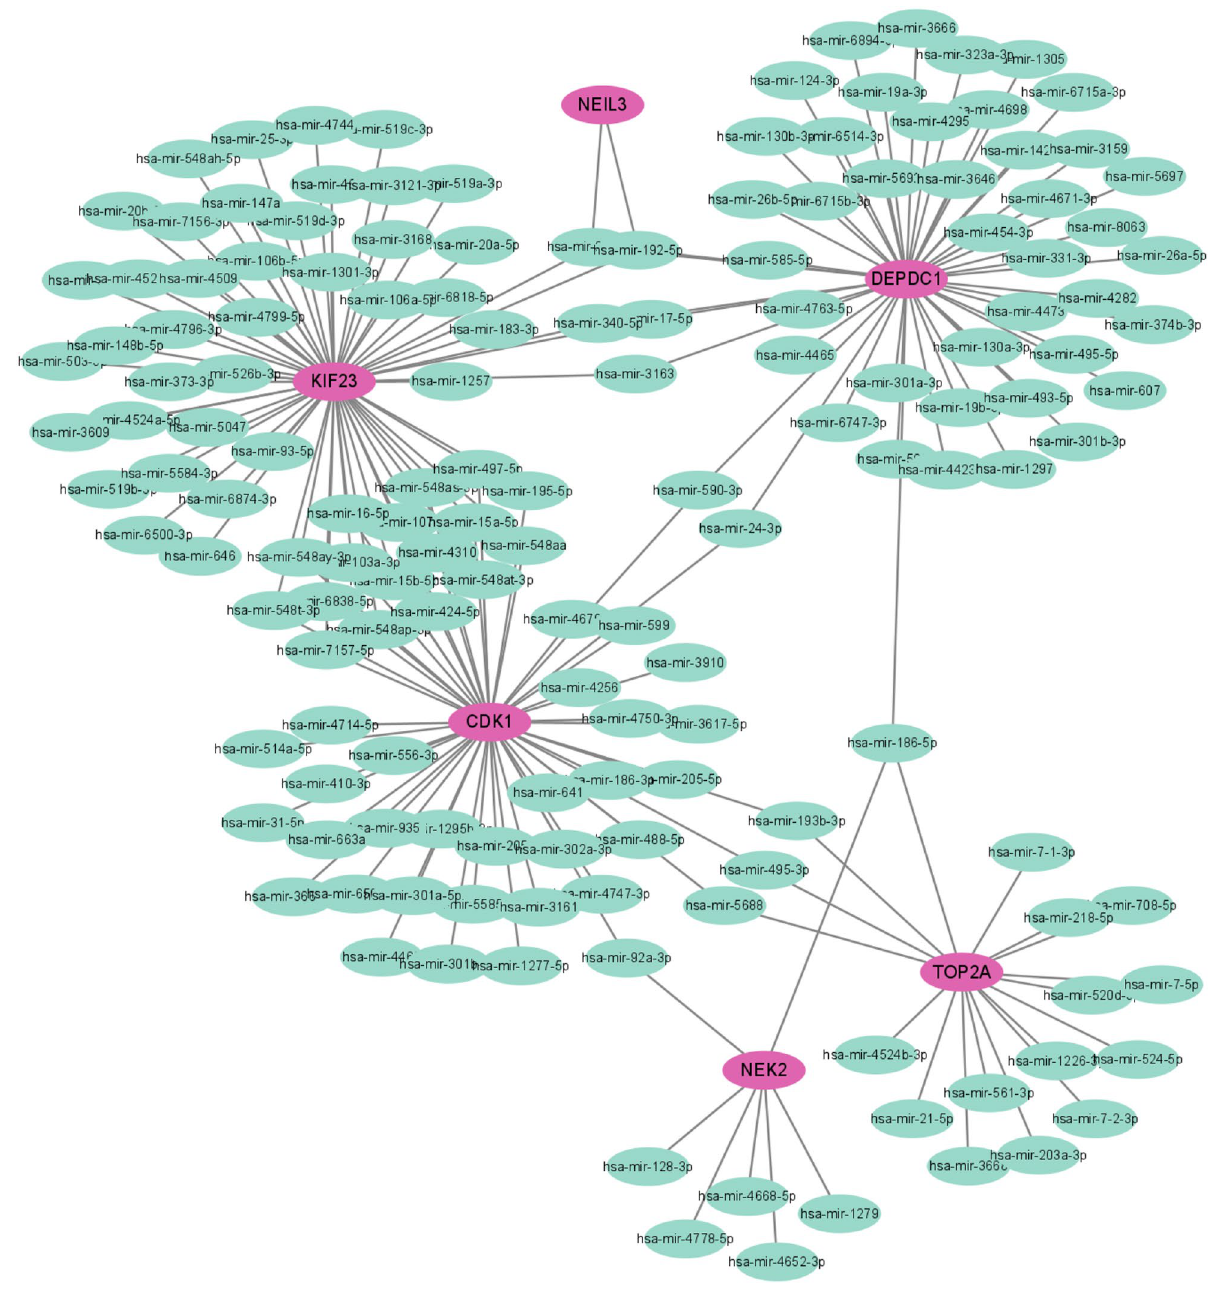
Figure 8. The miRNAs-gene regulatory network. Hub genes are represented by the pink nodes, and miRNAs are represented by the other green